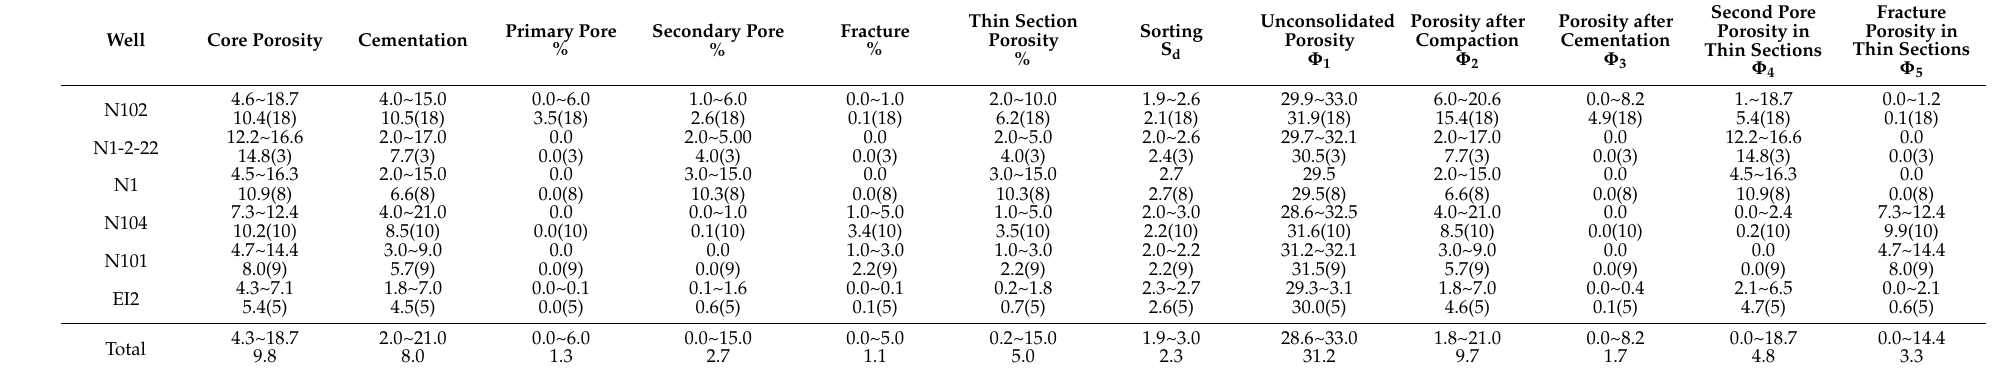
Table 3. Parameters for quantitative calculation of pore recovery in the Niudong